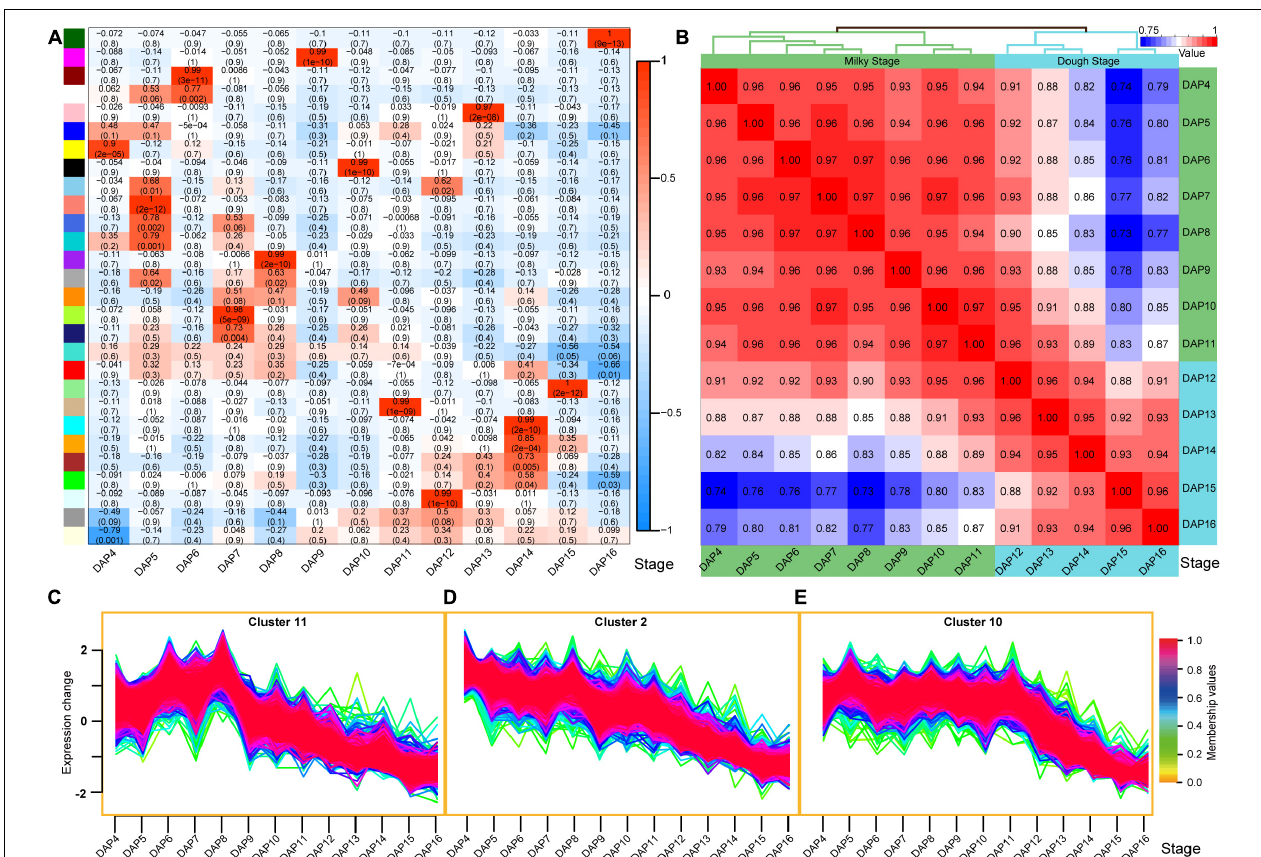
FIGURE 4 | Gene expression patterns during seed development. (A) Correlation between the developmental stages and expression modules. A total of 28 modules were identified by the weighted correlation network analysis (WGCNA), of which 13 modules are highly correlated with 13 developmental stages ( r > 0.9). (B) Pearson correlation of the 13 stages based on all of the expressed genes. These stages are divided into two groups, which corresponded to the milky and dough period. (C–E) Typical gene expression clusters. Cluster 11 indicates high expression in the first five stages and low expression in the subsequent stages (C) ; cluster 2 means that gene expression level was decreasing during seed development (from DAP4 to DAP16) (D) ; cluster 10 indicates high expression in the milky period and low expression in the dough period (E) .